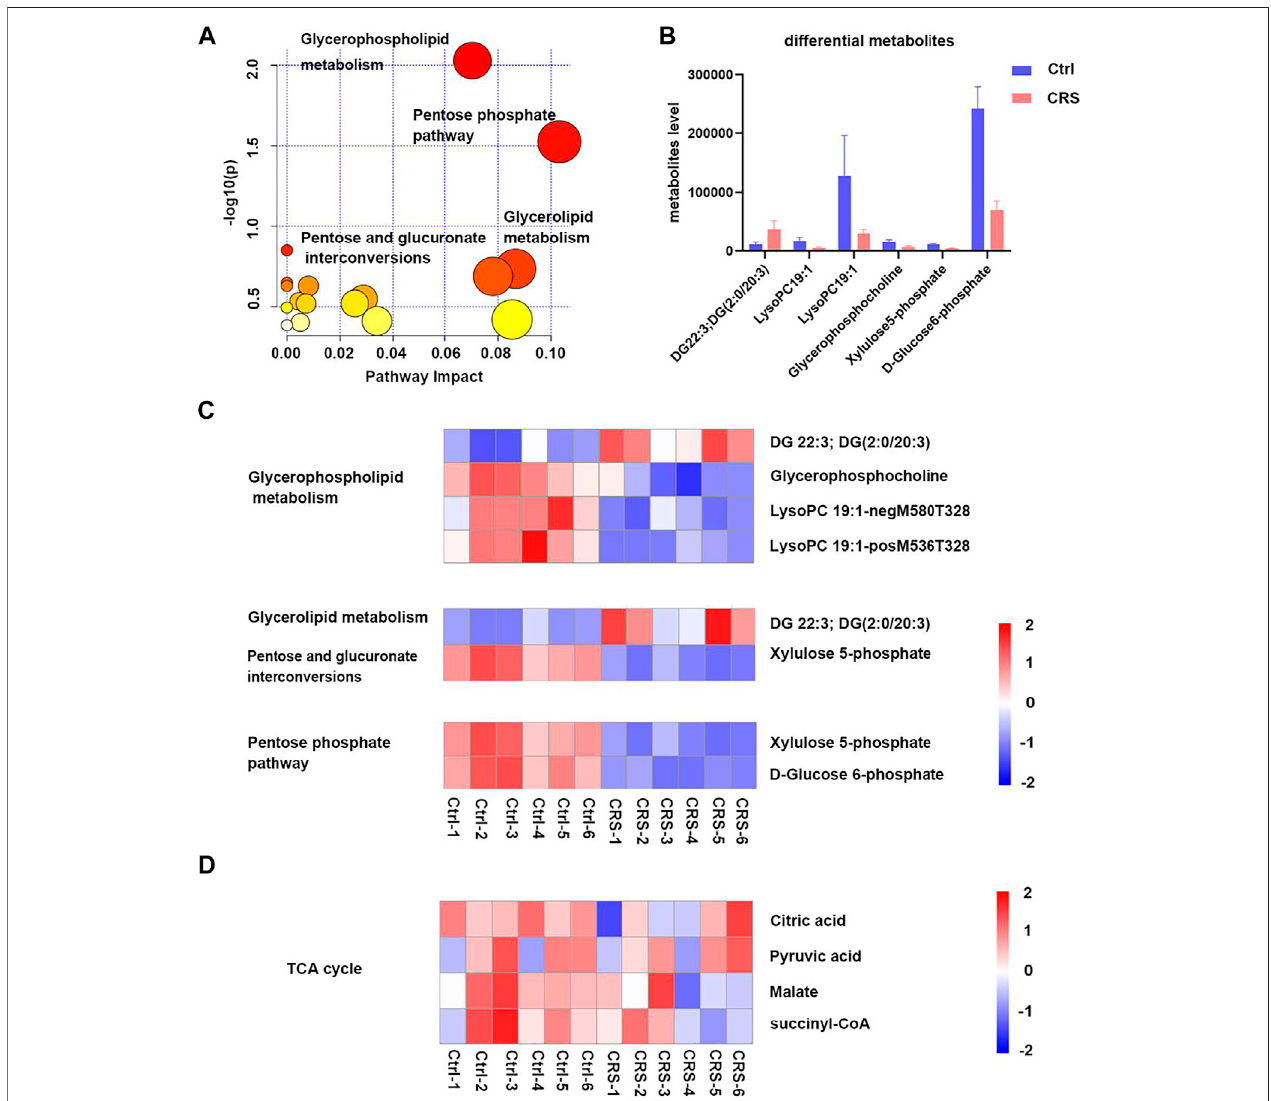
FIGURE 3 | CRS signi fi cantly affects the pro fi les of secondary metabolites in skin tissues. (A) Scatterplot of enriched KEGG pathways in secondary metabolites whencomparingCRSgroupwithcontrolgroupusingtheMetaboAnalyst5.0pathwayanalysismodule.Topenrichedmetabolicpathwayswerelabeled. (B) Comparison of secondary metabolites level between control group and CRS group in the top 4 signi fi cant pathways. (C) Heatmap analysis showed differential metabolites in glycerophospholipid metabolism, pentose phosphate pathway, glycerolipid metabolism, pentose and glucuronate interconversions pathways. (D) Heatmap analysis showed metabolites changes in TCA